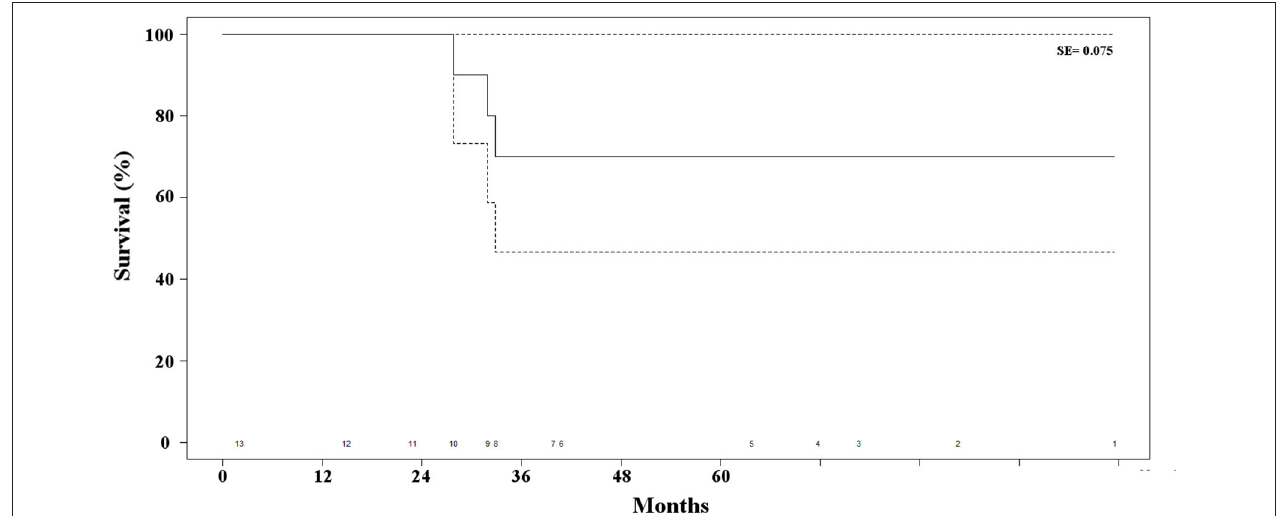
FIGURE 3 | Kaplan-Meier estimate of survival of the patients’ series. The dotted lines represent the standard error (SE) and the numbers at the bottom of the graphic the number of patients at risk for each time